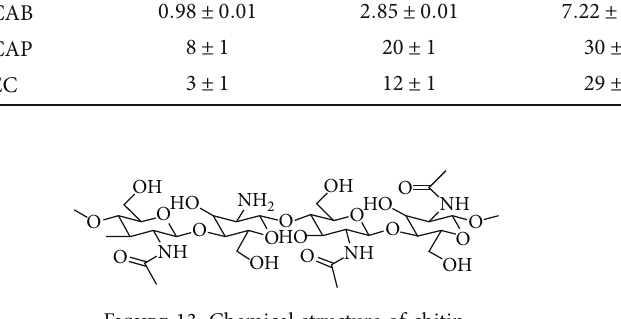
Figure 13: Chemical structure of